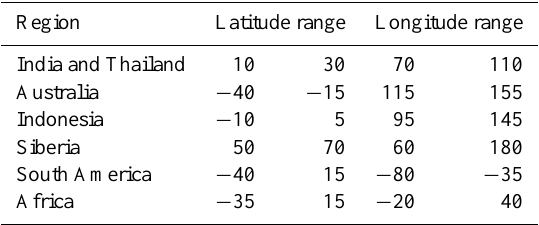
Table 1. Coordinates of areas used for regional burdens and emis- sions in degrees (negatives are for S and W). Region Latitude range Longitude range India and Thailand 10 30